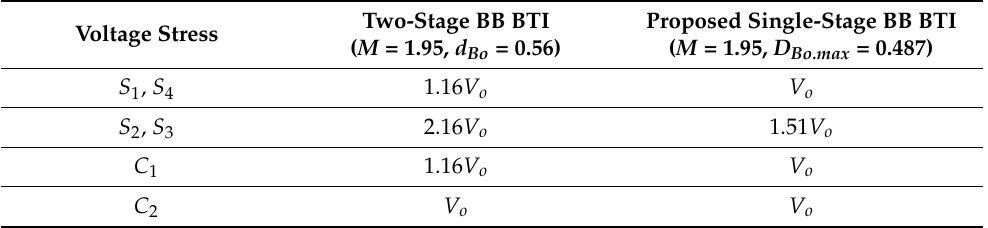
Table 2. Comparison of conventional two-stage BB-BTI with the proposed single-stage BB-BTI with the same modulation